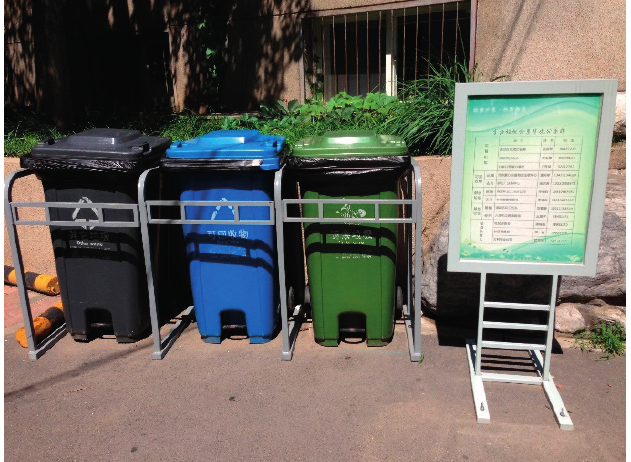
Figure 1. A set of community garbage bins: other waste, recyclable waste and kitchen waste (from left to